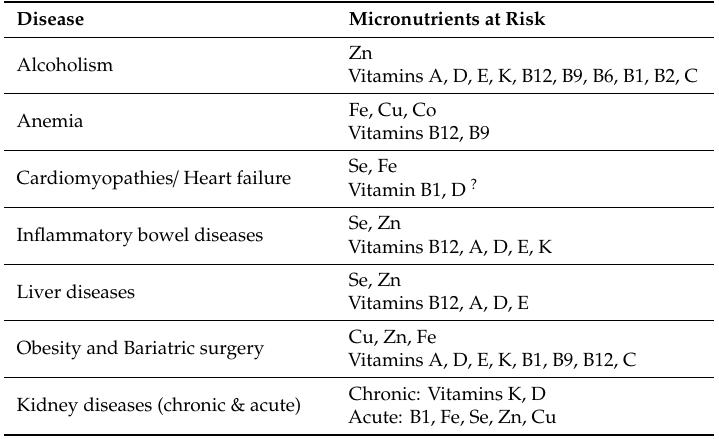
Table 2. Disease specific vitamins and in trace elements